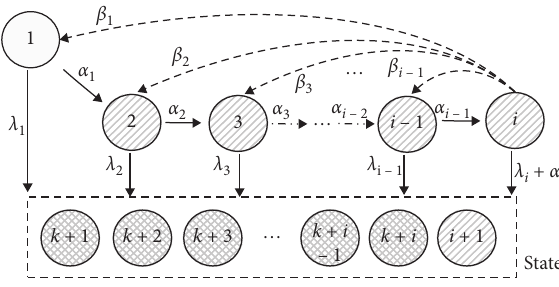
Figure 3: State transition diagram for determination of R ( t )